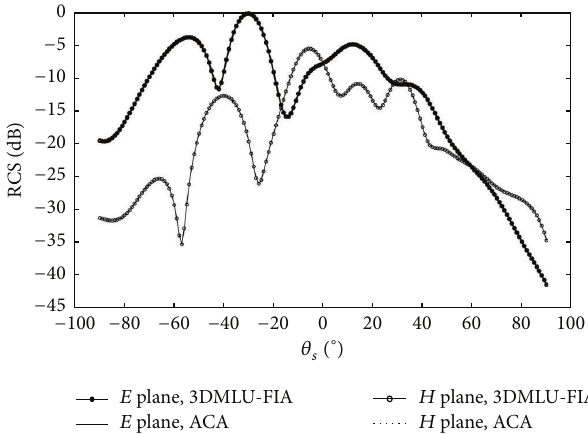
Figure 4: Inner loops and iterative deviation 𝜍 𝑛 vary from iterative steps 𝑛.